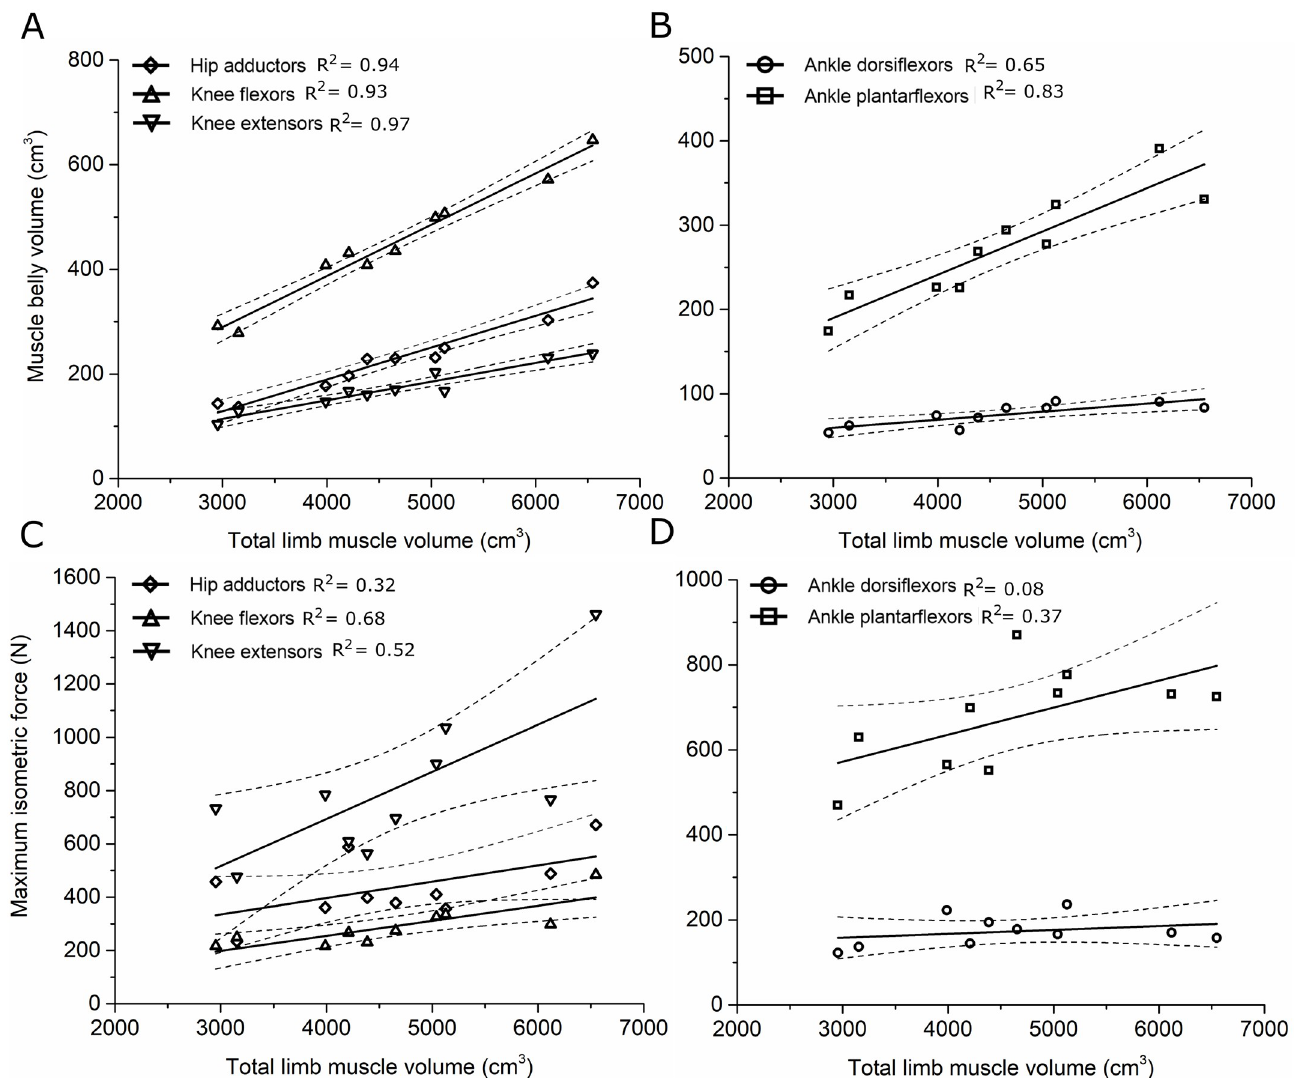
Fig 2. The scaling relationships between: Individual total limb muscle volume and total muscle belly volume in the (A) hip adductors, knee flexors and knee extensors; (B) ankle dorsiflexors and ankle plantarflexors; and maximum isometric force in the (C) hip adductors, knee flexors and knee extensors; (D) ankle dorsiflexors and ankle plantarflexors. Dotted lines represent ± 1 standard error mean.